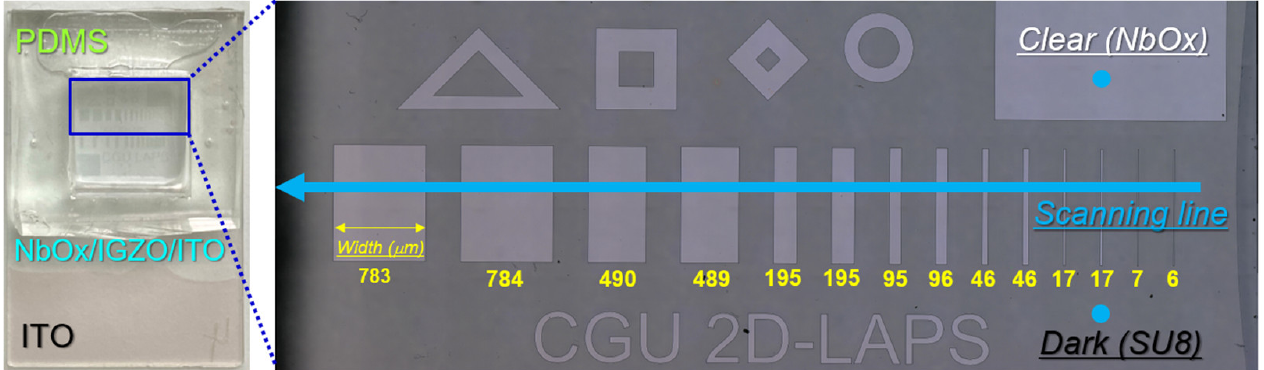
Figure 1. The fabricated IGZO LAPS sample with SU8 photosensitive epoxy and PDMS encapsulation on the NbOx surface. The ITO layer is exposed as the backside contact of IGZO LAPS. The clear and dark zones for PC-V curve measurement and the scanning line of the spatial resolution check for the patterns with different widths are all marked in the picture captured by an optical microscope.